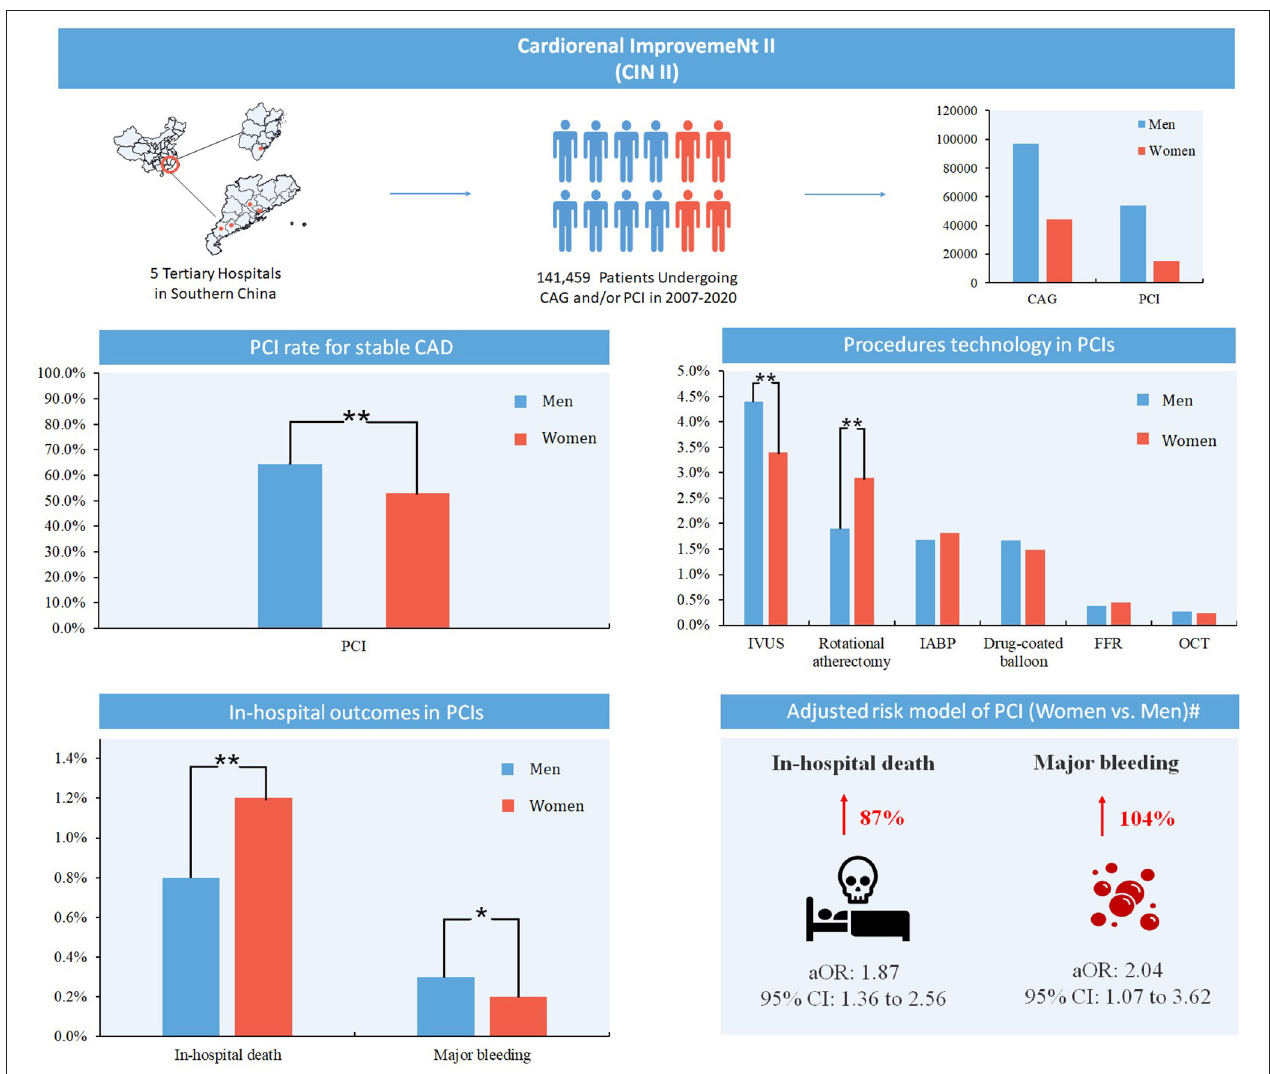
FIGURE 2 | Centre illustrations. CAG, coronary angiography; PCI, percutaneous coronary intervention; CAD, coronary artery disease; IVUS, intravascular ultrasound; IABP, intra-aortic balloon pump; FFR, fractional flow reserve; OCT, optical coherence tomography. **: P < 0.001; *: P < 0.05. #: Adjusted for age, acute myocardial infarction, hypertension, diabetes mellitus, congestive heart failure, chronic kidney disease, atrial fibrillation, stroke, hyperlipemia, prior myocardial infarction, prior percutaneous coronary intervention, hemoglobin and dual-antiplatelet therapy.